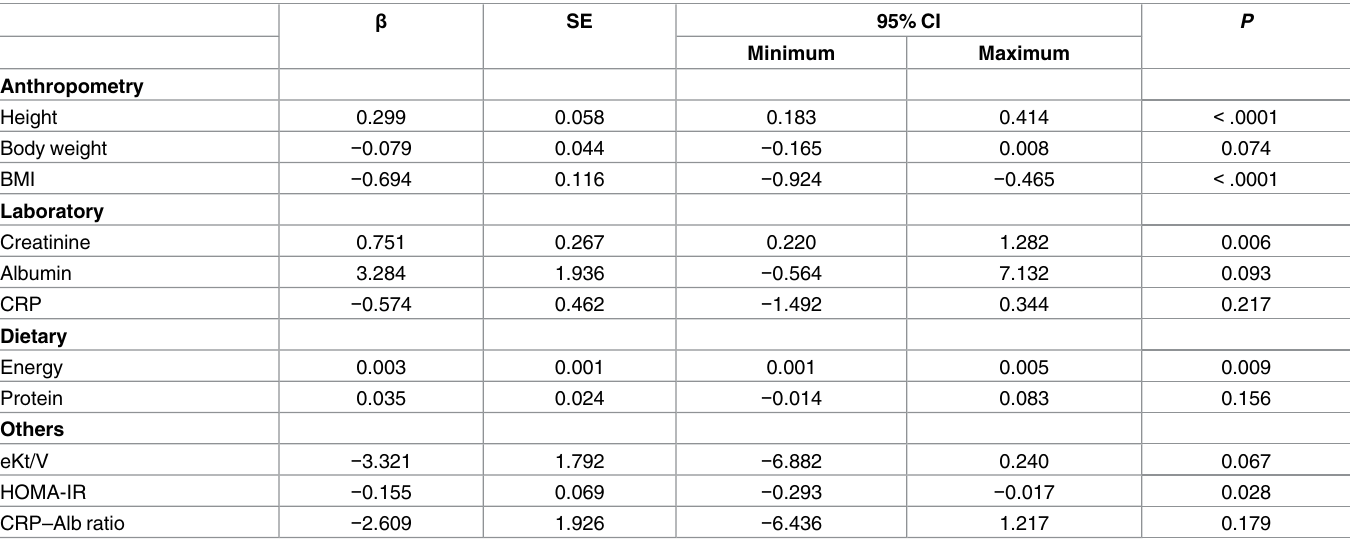
Table 3. Simple regression analysis using SMM/wt as a dependent variable 1